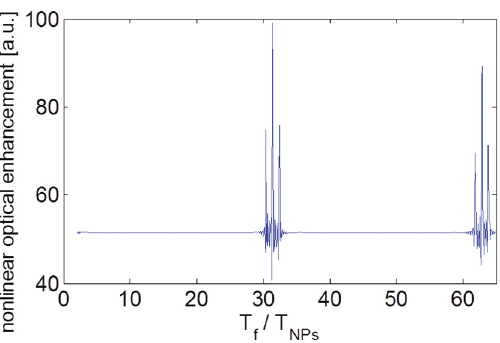
Figure 5: Third order nonlinear optical enhancement as a function of Tf/TNPs.